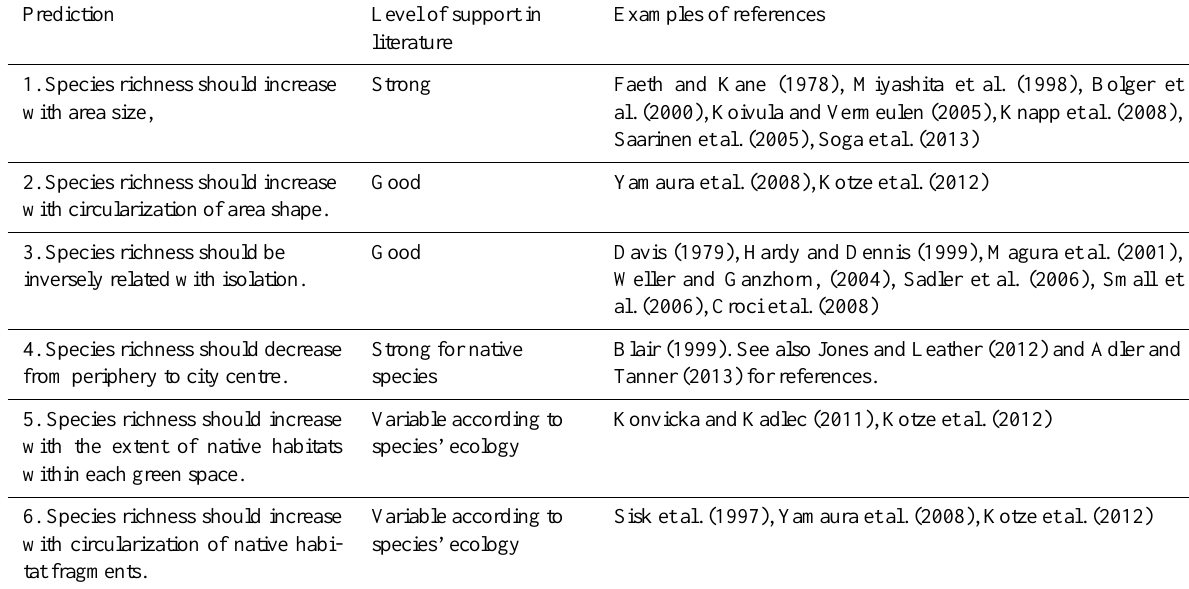
Table 1. Examples of studies supporting predictions about species richness in urban green